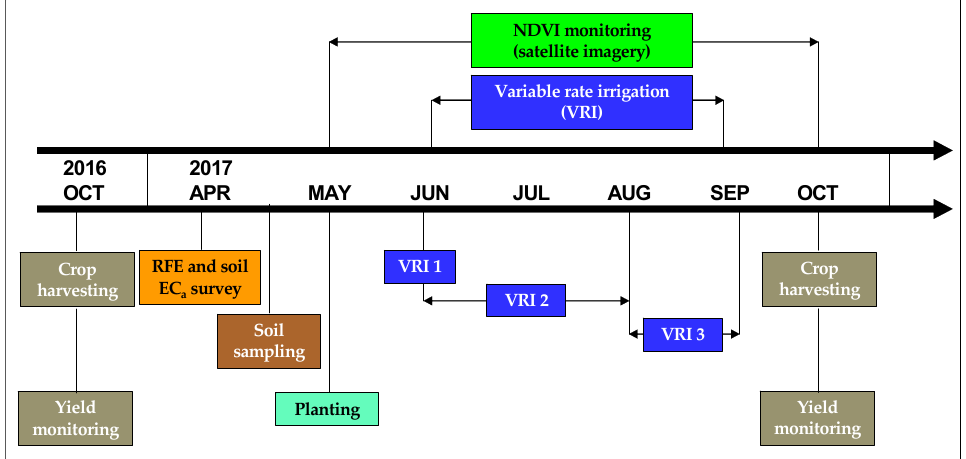
Figure 2. Chronological diagram of the tasks carried in this study (NDVI — Normalized Difference Vegetation Index, VRI — Variable Rate Irrigation, RFE — Relative Field Elevation, EC a — Soil Electrical Conductivity Apparent).